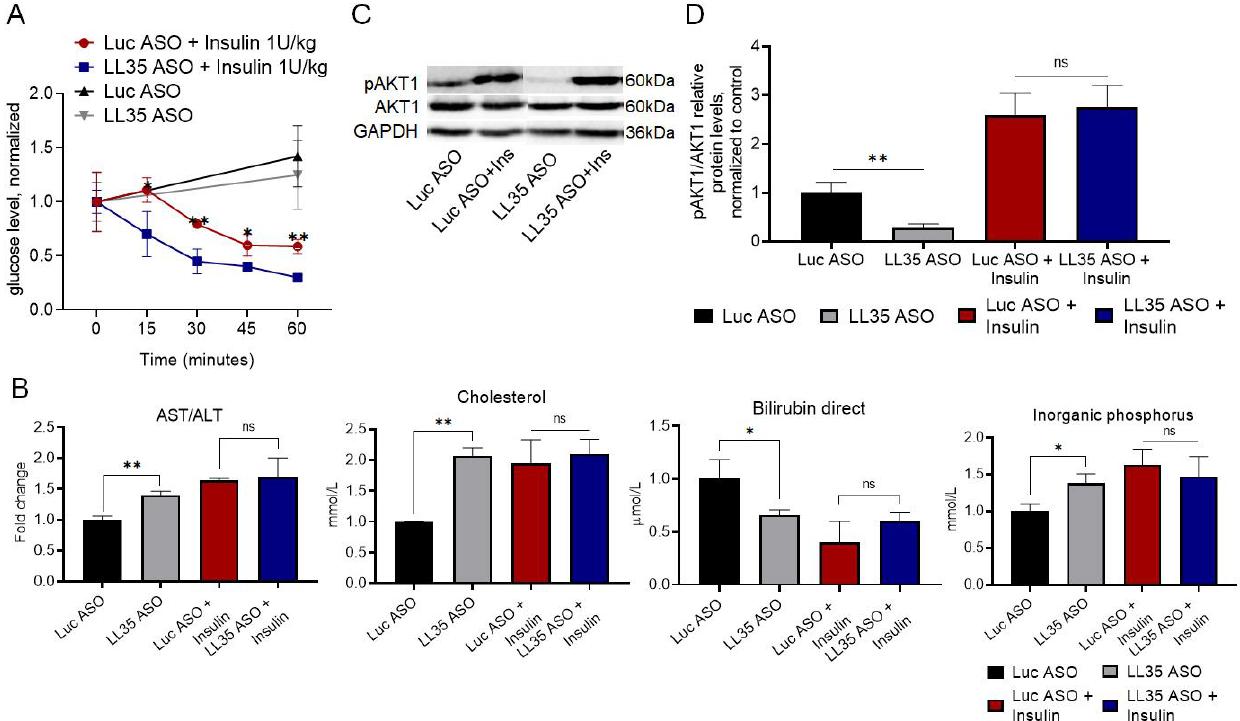
Figure 6. The influence of insulin in mediating the effects of LL35 depletion. ( A ) Insulin tolerance test in vivo. Glucose blood level in mice was measured each 15 min for 1 h after insulin injection (1 U/kg). LL35 ASO—mice with depleted LL35, Luc ASO—control mice. ( B ) Biochemical parameters of mice blood at day 5 after LL35 depletion (LL35 ASO) in comparison to control mice (Luc ASO). Insulin treatment compensates these differences. ( C ) Western blot of pAKT1 and AKT1 proteins in AML12 cells after LL35 knockdown (LL35 ASO) and control (Luc ASO) with 100 nM (+Ins) or without insulin treatment. ( D ) Quantification of pAKT1/AKT1 ratio for AML12 cells after LL35 knockdown and insulin treatment. Results show mean ± SD. ns—not significant. * p < 0.05, ** p <